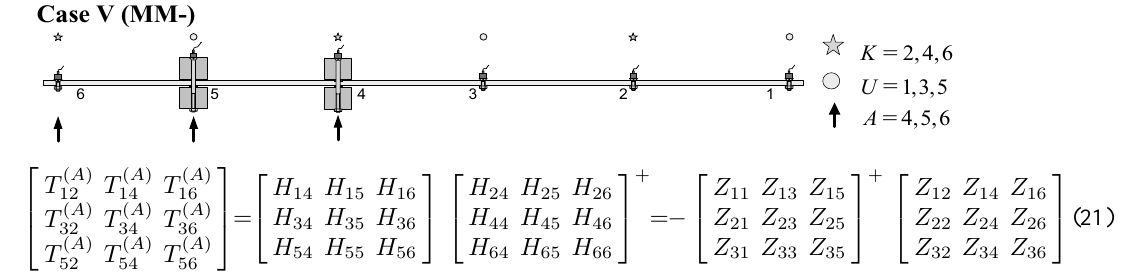
the inversion process which is intimately related to the calculation of the determinant of matrices H KA for the traditional inversion